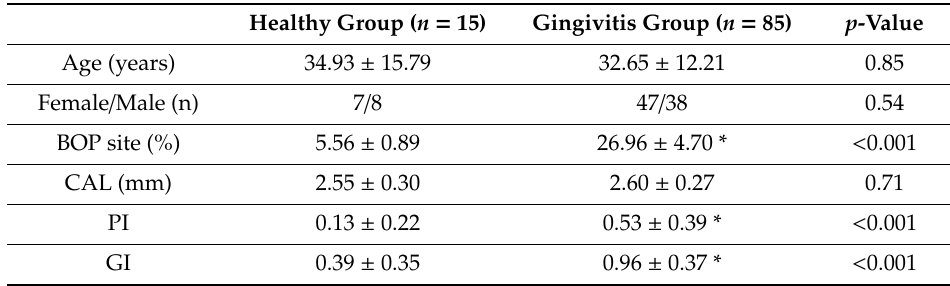
Table 1. Distribution of study subject characteristics (mean ± standard deviation) in healthy and gingivitis group.